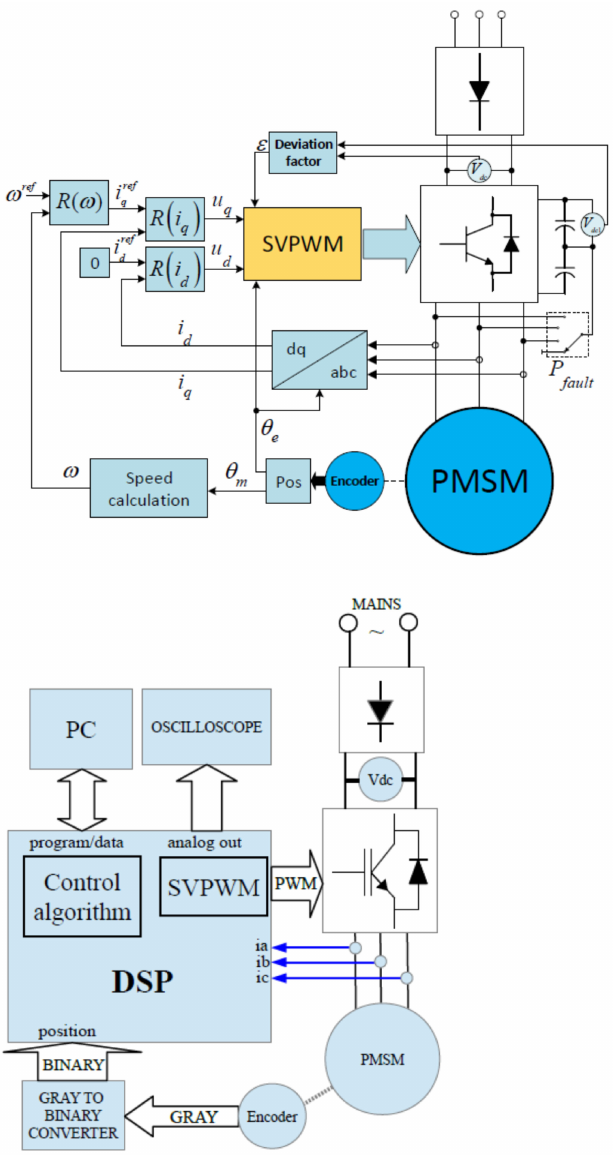
Figure 3. Block diagram of closed-loop vector control ( top ), the general structure of the laboratory stand ( bottom